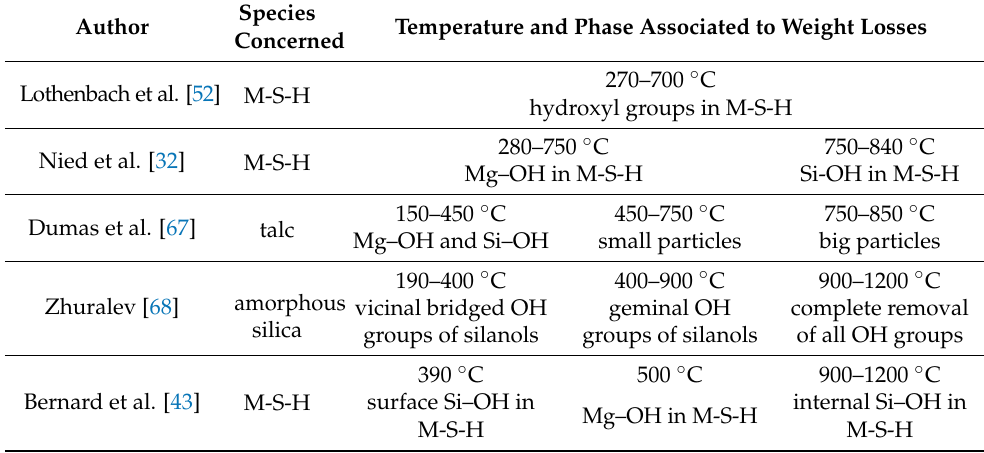
Figure 10. TGA results of three M-S-H pastes with colloidal silica after 4.5 months of a 50 ◦ C curing and two M-S-H powders synthetized by Bernard et al. [43] (dashed lines, noted B*). Manual mixing was used for pastes M/S = 0.78 and M/S = 1.3; mechanical mixing was used for M/S = 1. Table 4. Different attributions of weight losses in TGA for M-S-H or correlated